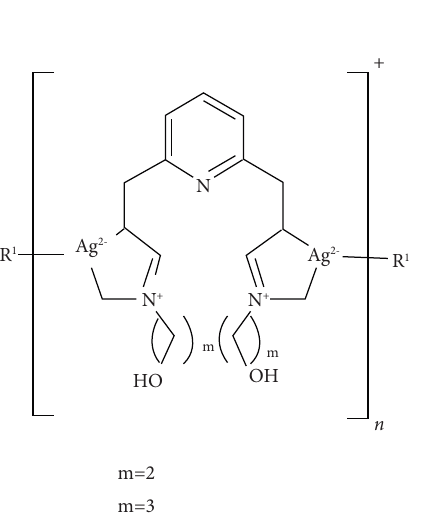
Figure 1: Silver